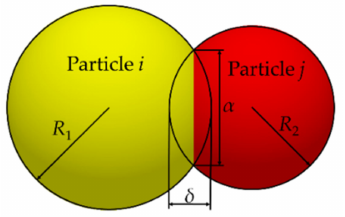
Figure 4. Hertz–Mindlin with JKR contact